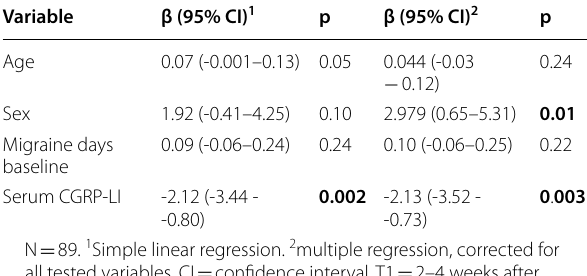
Table 3 Linear regression analysis with log-transformed serum CGRP-LI levels (mol/l) T1